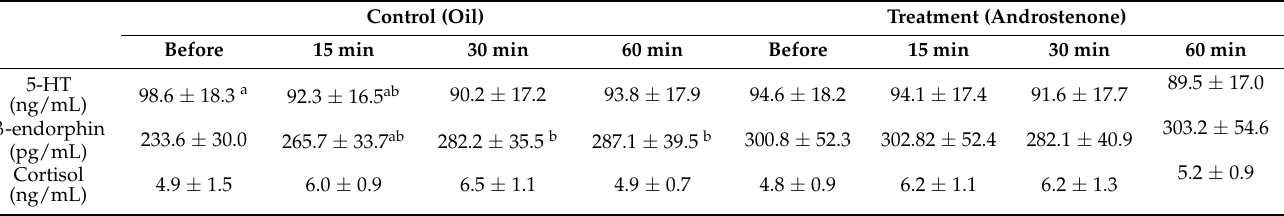
Table 1. Time dependent plasma 5-HT, β -endorphin, and cortisol concentrations of androstenone-treated and untreated